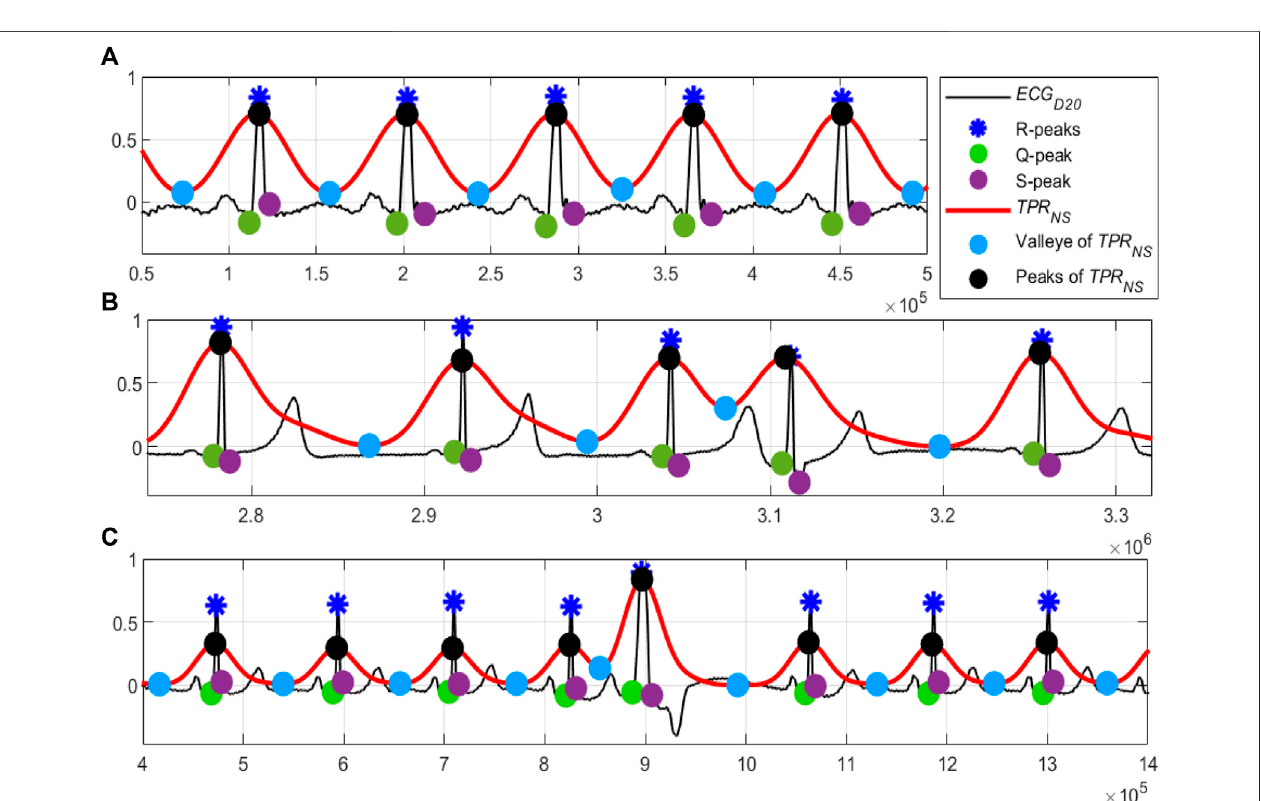
FIGURE 7 | (A) Normal sinus rhythm; record #122m, MITDB, (B) the 4 th QRS-complex is an APC beat; record #113m, MITDB and (C) the 5 th QRS-complex is a PVC beats;record#119m,MITDB. The ECG D 100 signals,theircorresponding TPR NS ,andtheR-peaksineach ofthethreesub- fi gures areshowninblack, red,andblue colours, respectively. The X and Y axes of all the three sub- fi gures are the number of samples and normalized amplitude, respectively.